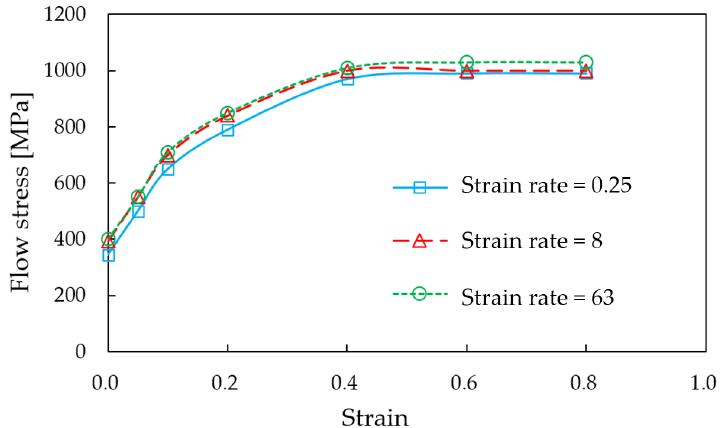
Figure 2. Flow curve of AISI-316 at room temperature.